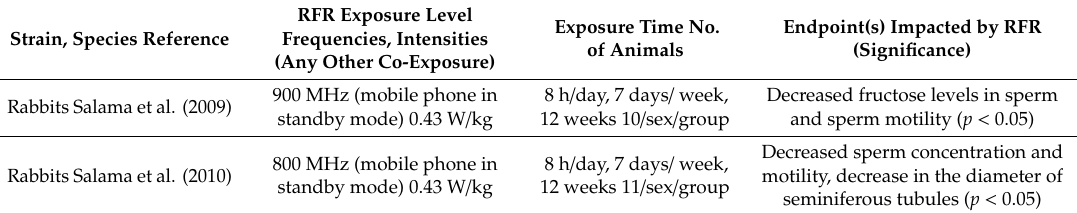
Table 6. Male reproductive studies in other models exposed to